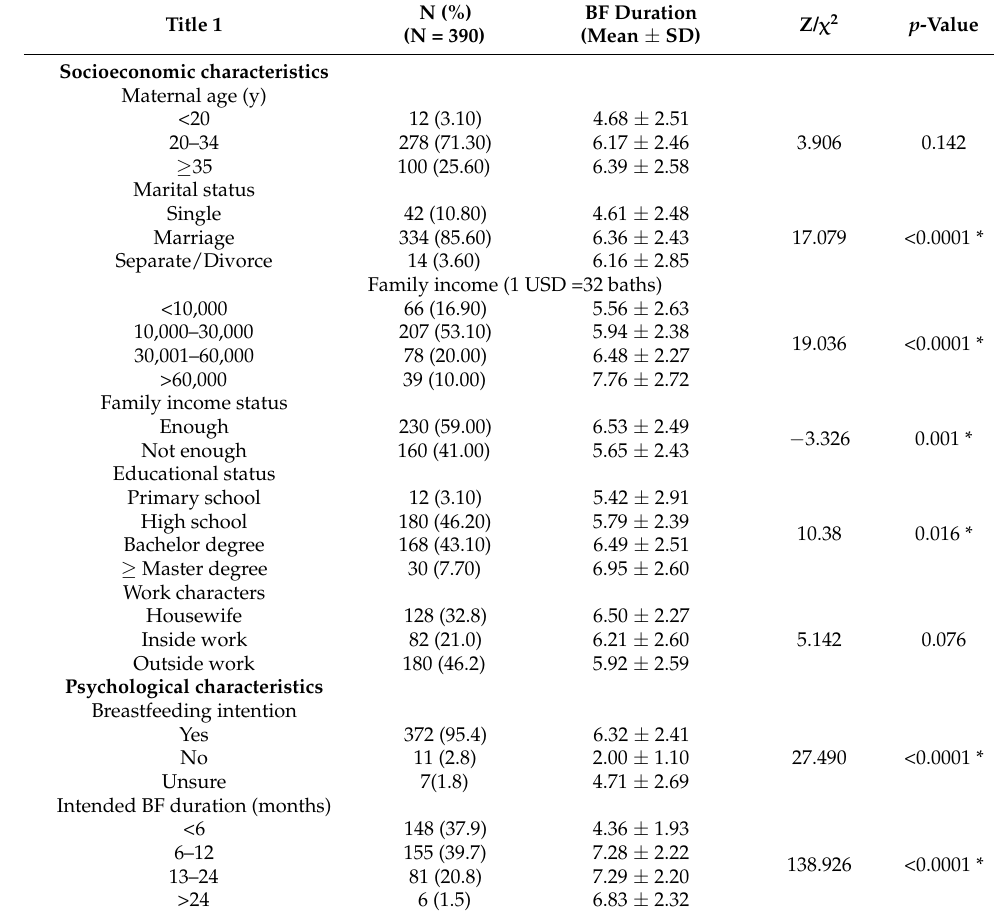
Table 1. Comparison of the breastfeeding duration in the first year of life according to the socioeco- nomic characteristics and psychological